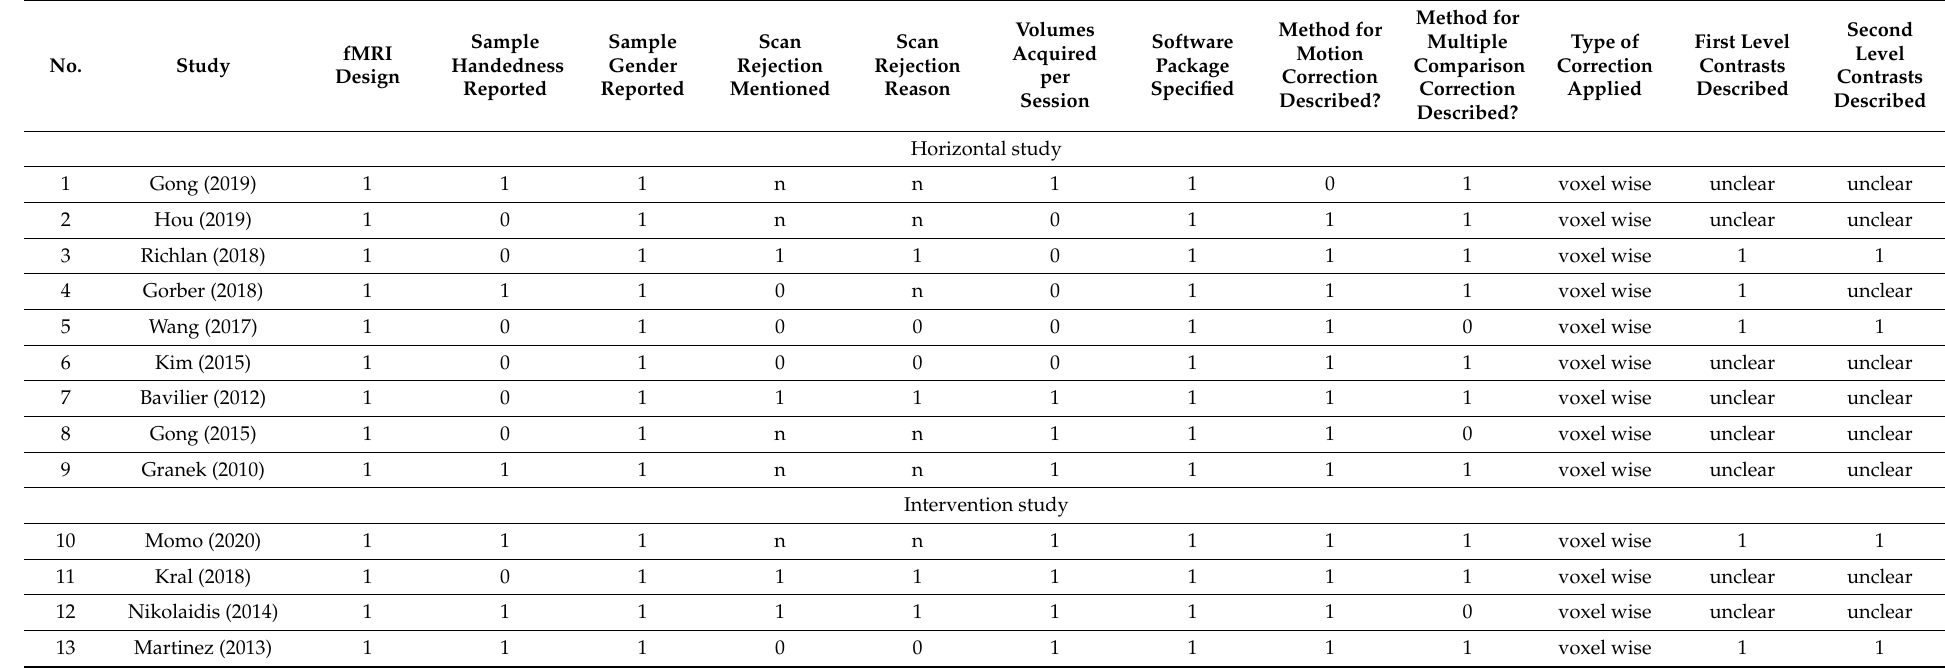
Table 3. Summary of fMRI